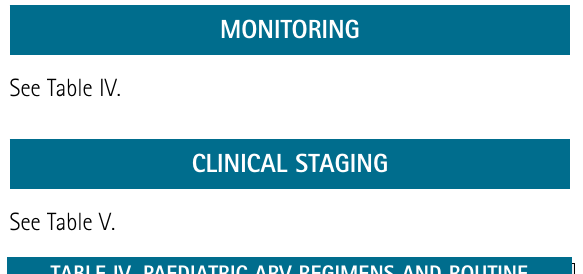
TABLE IV. PAEDIATRIC ARV REGIMENS AND ROUTINE MONITORING DURING